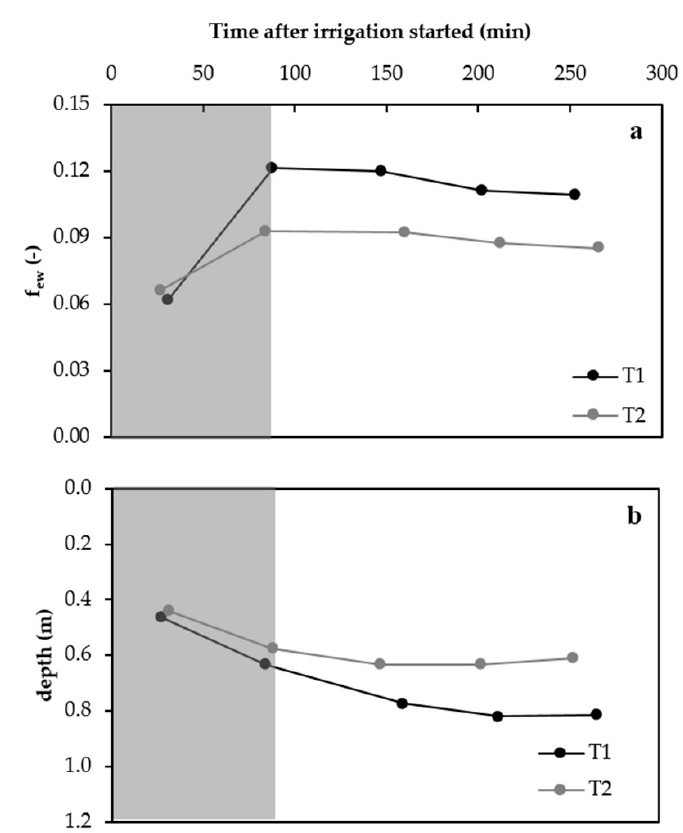
Figure 2. Evolution of the exposed wetted area (f ew ) ( a ) and evolution of the infiltration front depth (m) in T1 and T2 during and after an irrigation phase ( b ). Time is expressed in minutes after the irrigation start. The grey area represents the irrigation phase period.